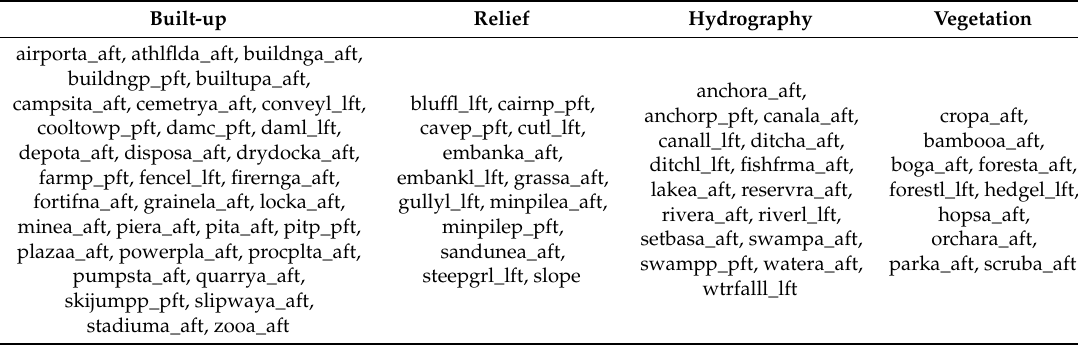
Table 2. Feature classes (according to DIGEST) used for generating passability maps according to specific feature